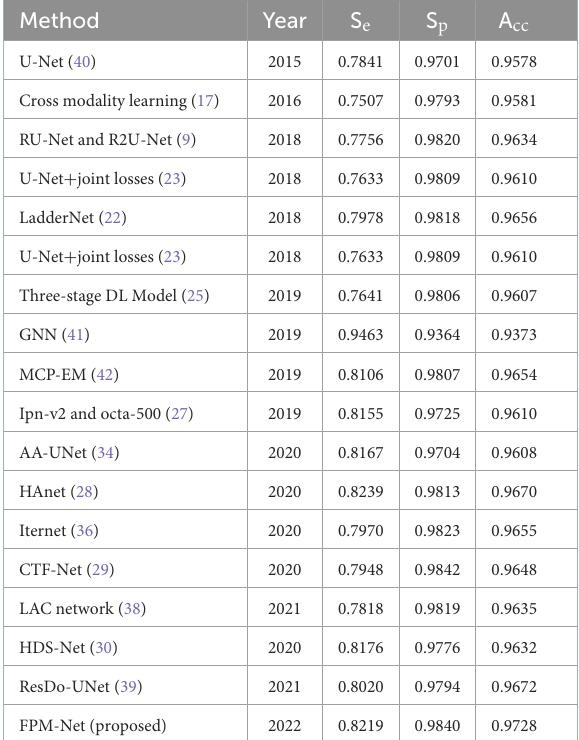
TABLE 3C The comparison of the STARE data set’s segmentation results using various segmentation